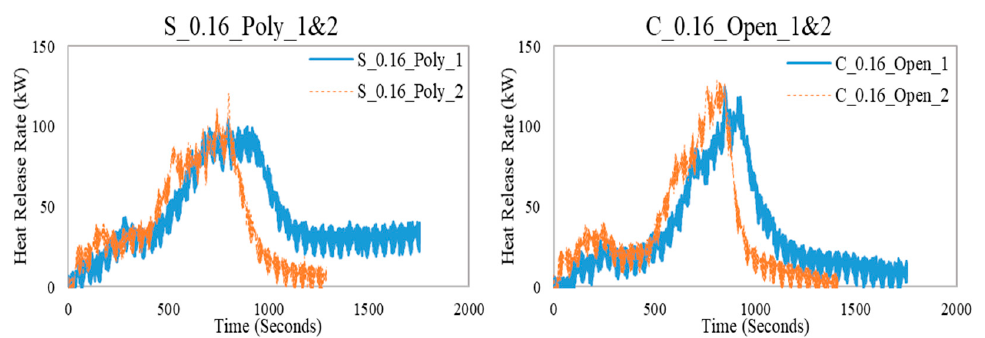
Figure 10. Repeatability check for two cases.